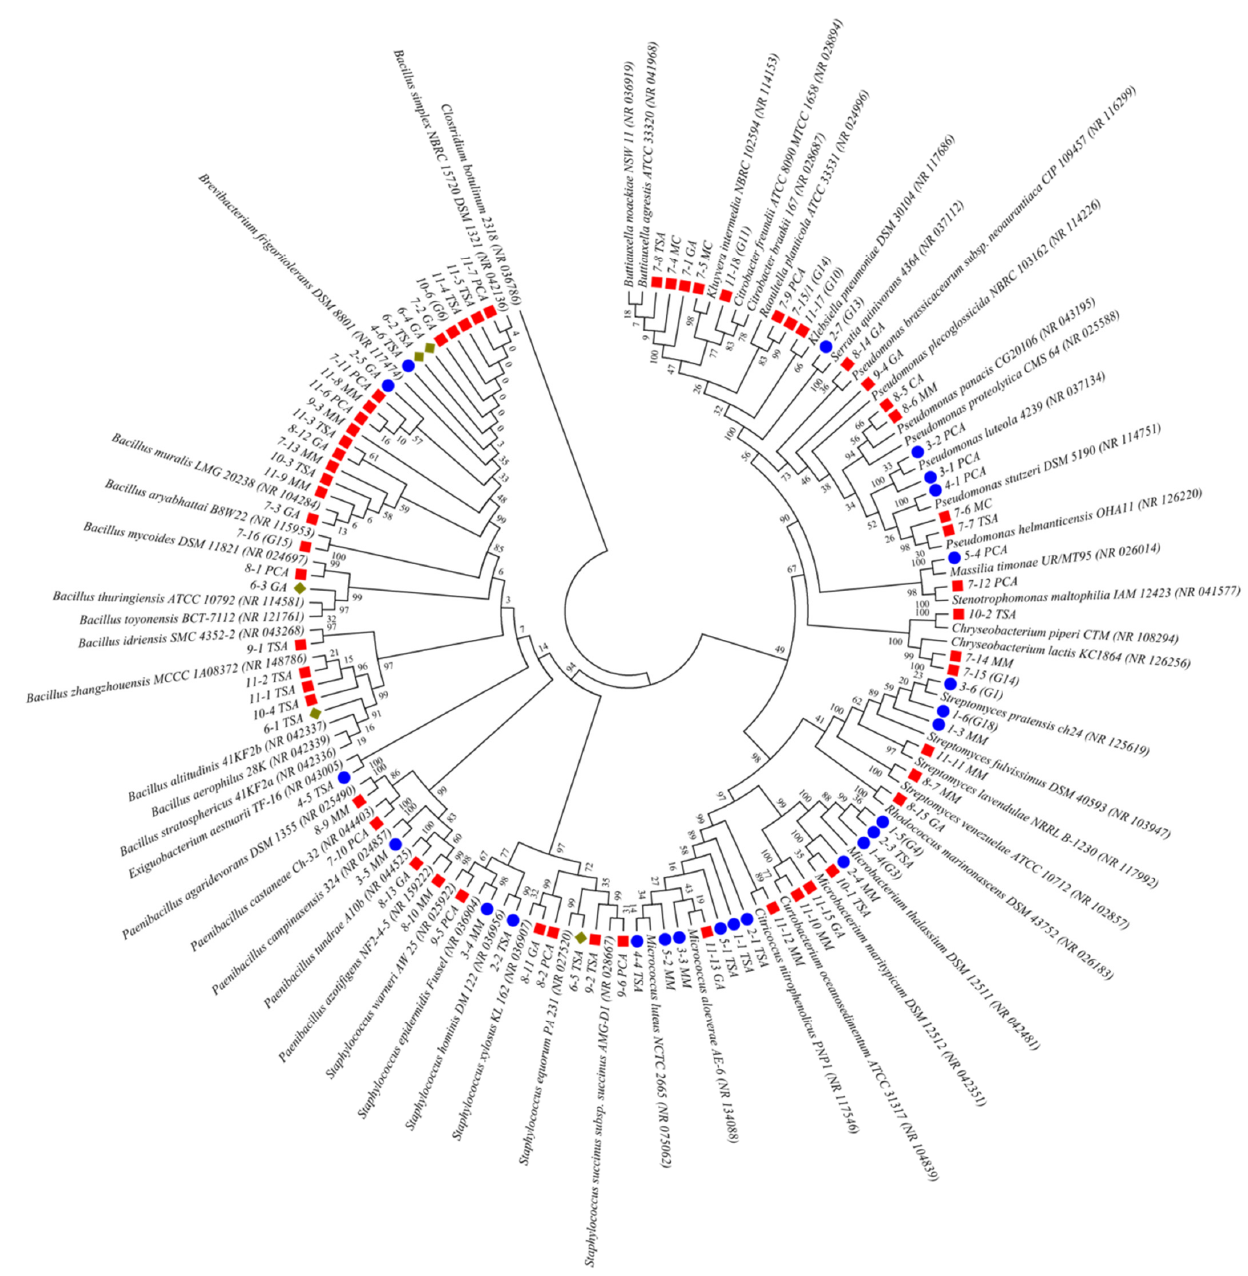
Figure 6. Neighbor-joining phylogenetic tree based on a pair-wise distance matrix with the Kimura two-parameter nucleotide substitution model, showing the relationship of the 16S rRNA sequences among obtained isolates from the Cave Church of Sts. Peter and Paul. The topology of the trees was evaluated by the bootstrap resampling method with 1000 replicates. Clostridium botulinum 2318 was used as an outgroup. ( • fresco isolates; (cid:4) around the fresco isolates; (cid:7) iconostasis